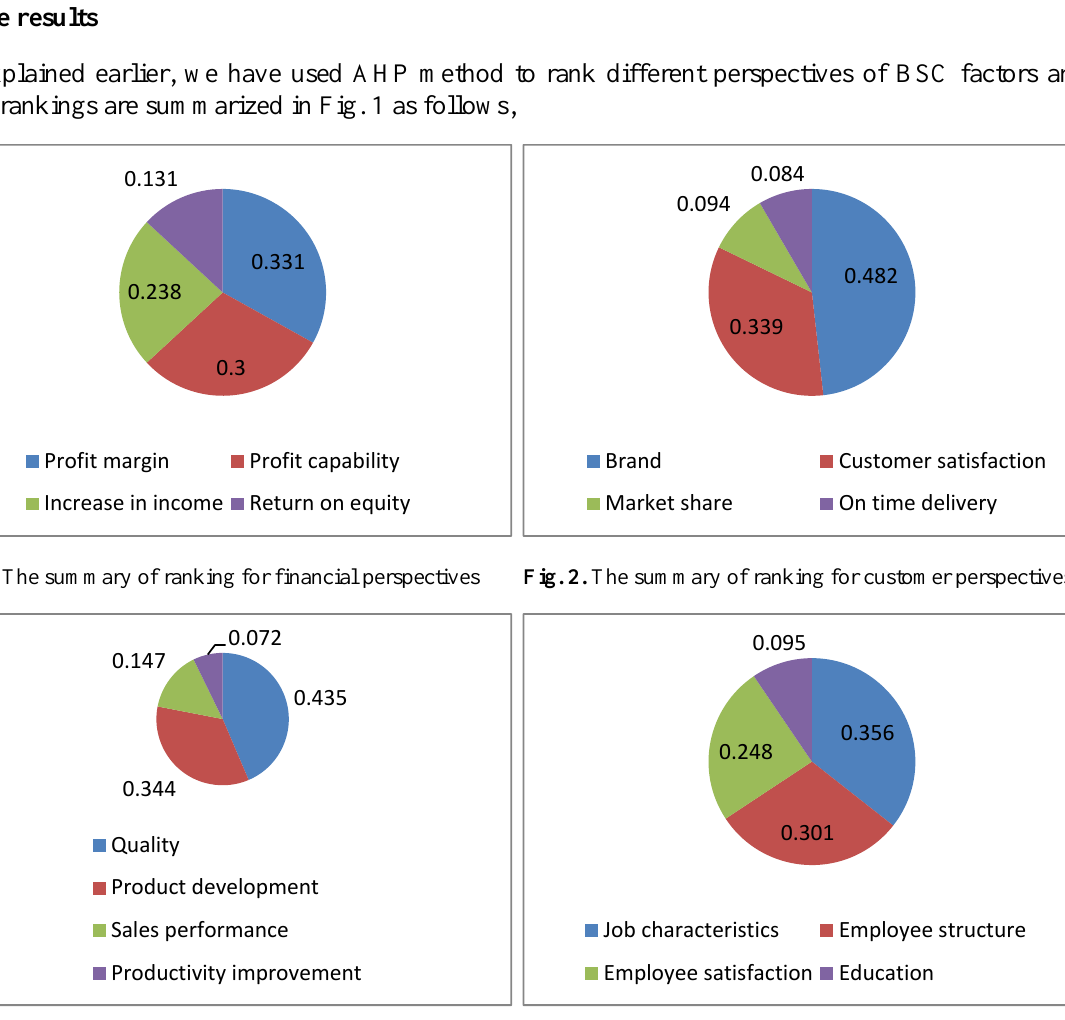
Fig. 3. The summary of ranking for internal processes Fig. 4. The summary of ranking for learning and